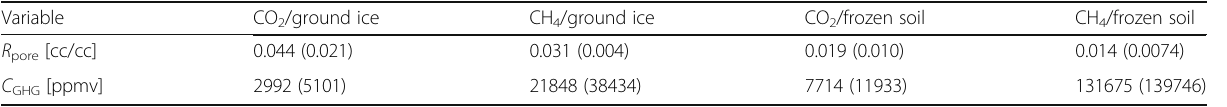
The average value and standard deviation for CO 2 and CH 4 are